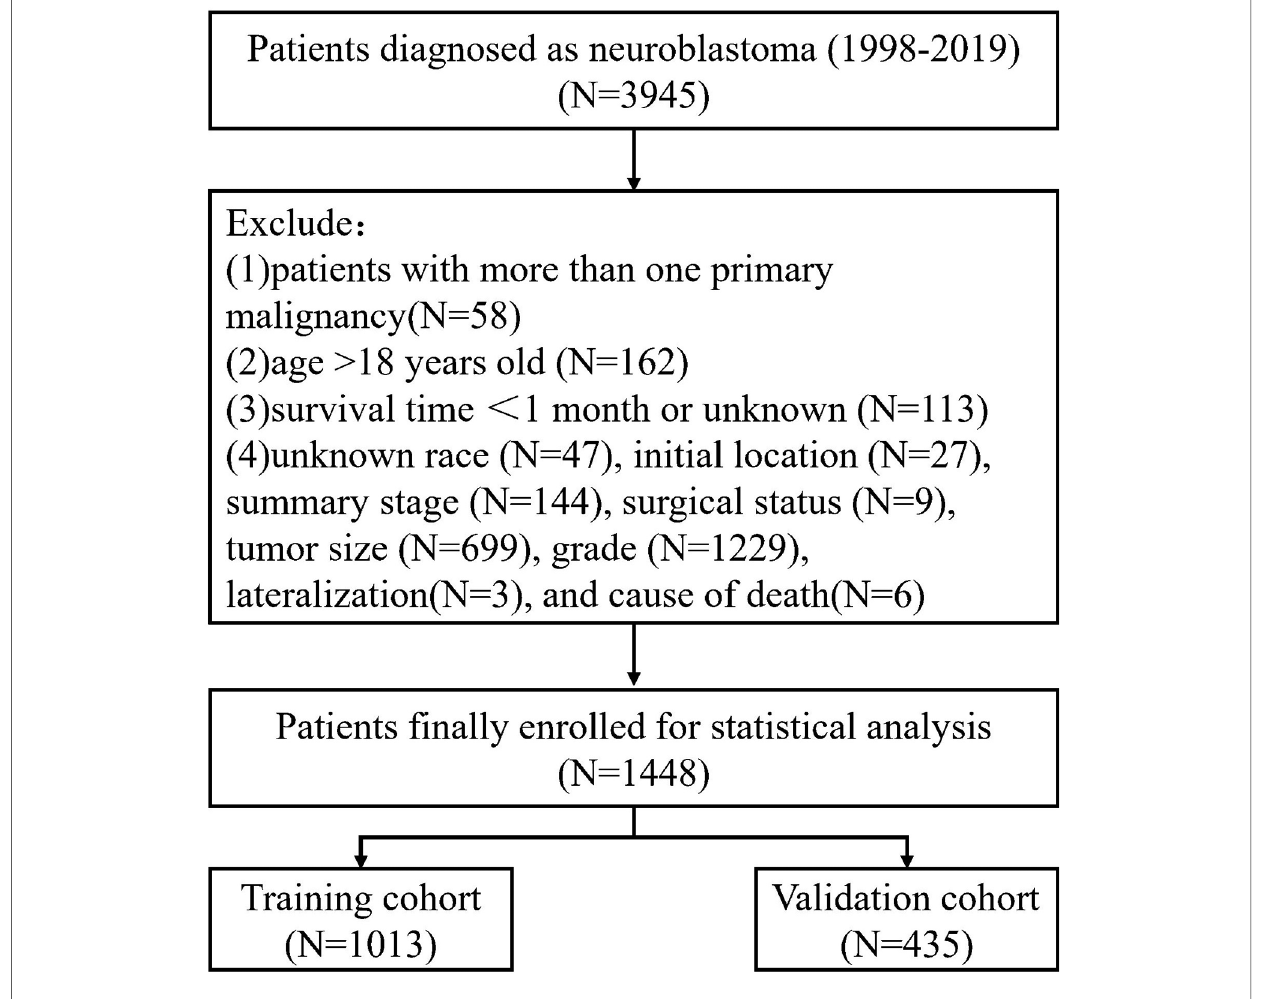
FIGURE 1 Flowchart of sample